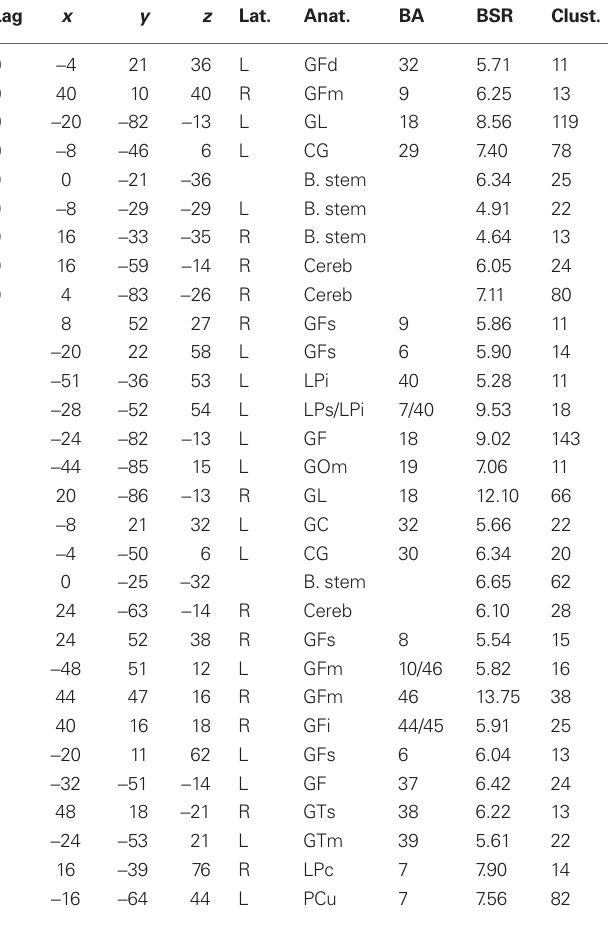
Table 1 | Cluster maxima from the behavior PLS (bPLS) analysis for the two-group analysis (LV